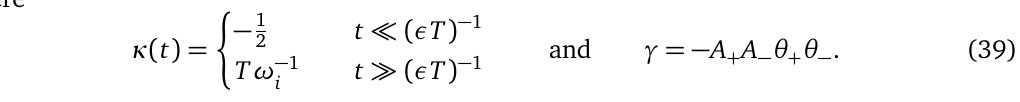
= 0.9, K = 0.6, time , K f i f